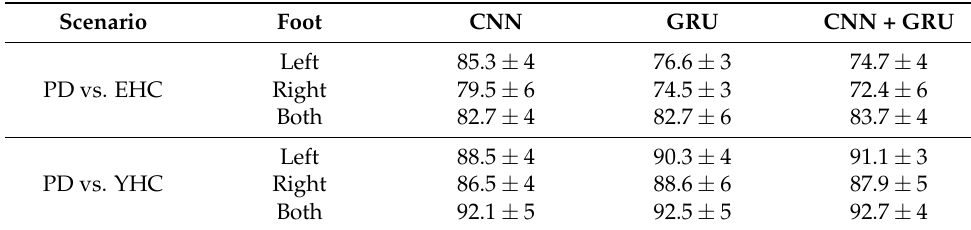
Table 8 summarizes the results obtained with the different architectures with the 4 × 10 task. Table 8. Summary of the accuracy in test for the best results considering the 4 × 10 m task.